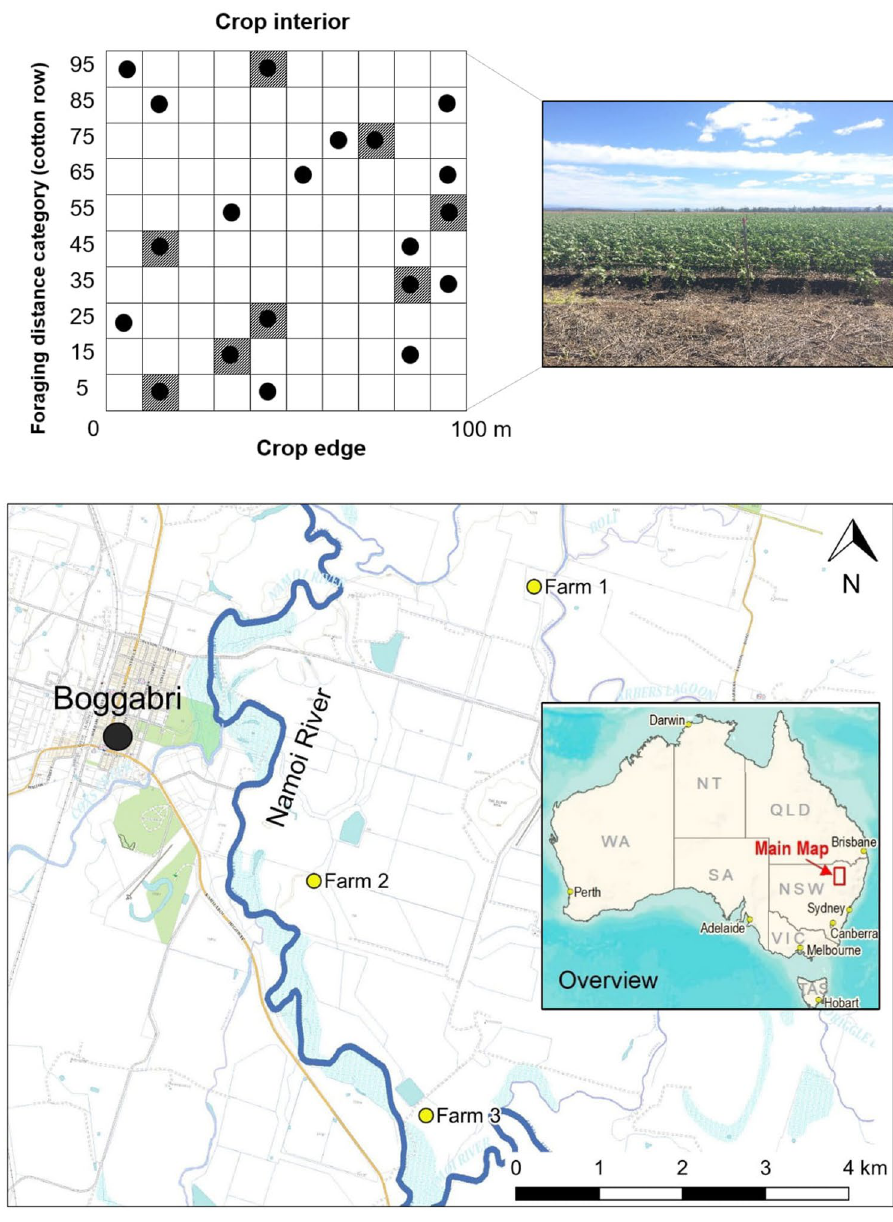
Figure 3. Location and example of the trial design at each farm showing a 100 × 100-m sampling area. The y-axis indicates the foraging distance (cotton row) from the edge of the cotton crop. Circles represent feeding stations (n = 20) and hatched cells indicate the location of a camera trap (n =